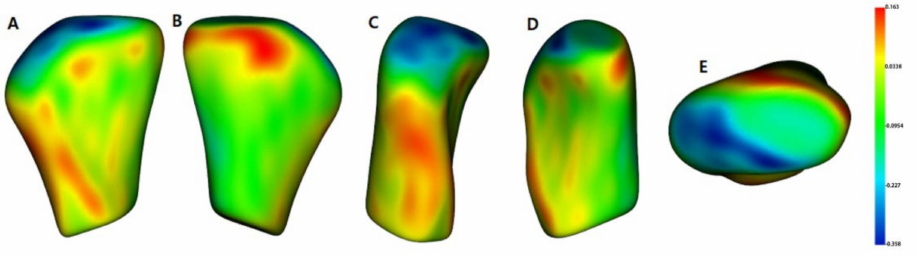
Figure 8. Group comparison using shape analysis—color maps pre-treatment (T1) and post-treatment (T2); ( A ), anterior view; ( B ), posterior view; ( C ), lateral view; ( D ), medial view; ( E ), superior